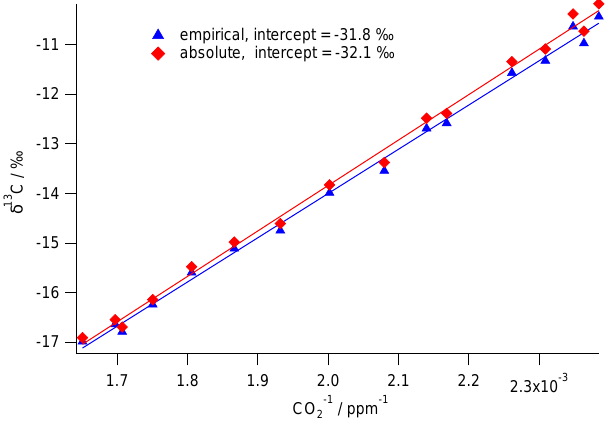
Fig. 14. Keeling plot of δ 13 C vs. 1/ χ CO ber closure from the data of Fig. 13. The two plots are derived from the absolute and empirical δ 13 C calibration methods described in Sect. 3.